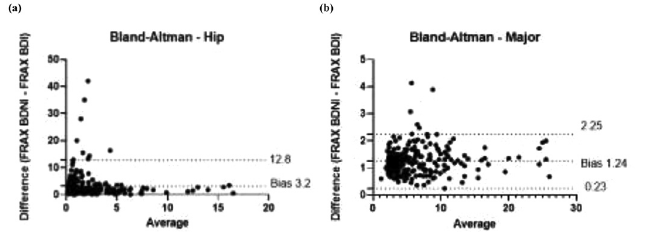
Fig. 2. Bland-Altman analysis for concordance between methods, comparing FRAX calculated with bone density not-included (FRAX BDNI) and FRAX calcu- lated with bone-density included (FRAX